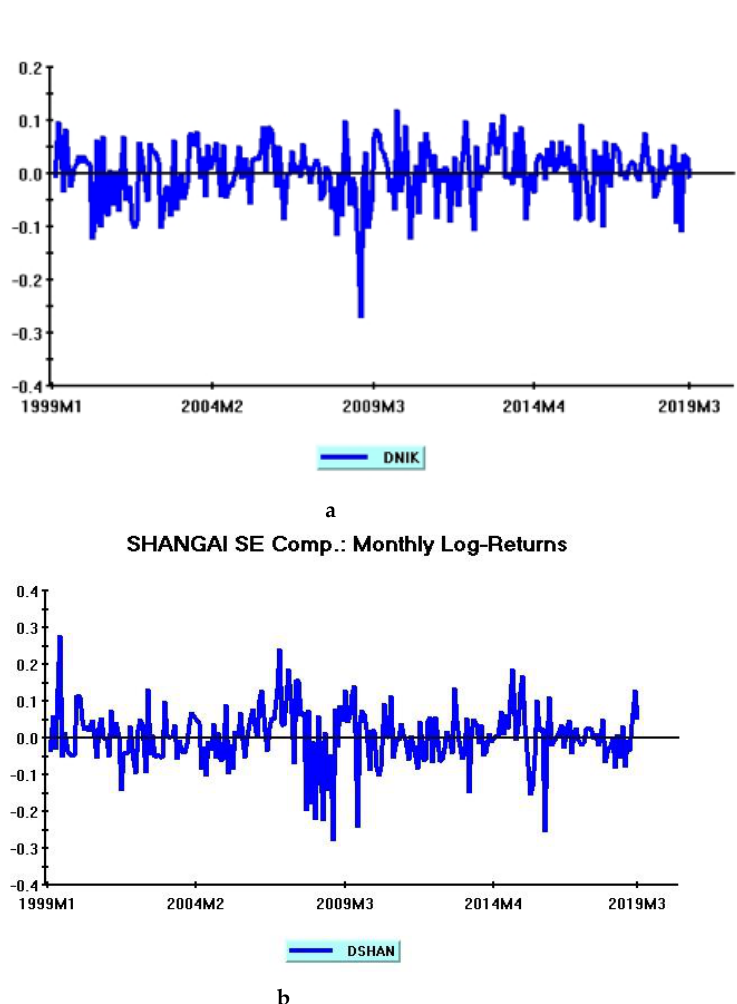
Figure 2. ( a ) NIKKEI 225: Monthly Log-Returns; ( b ) SHANGAI SE Comp.: Monthly Log-Returns.